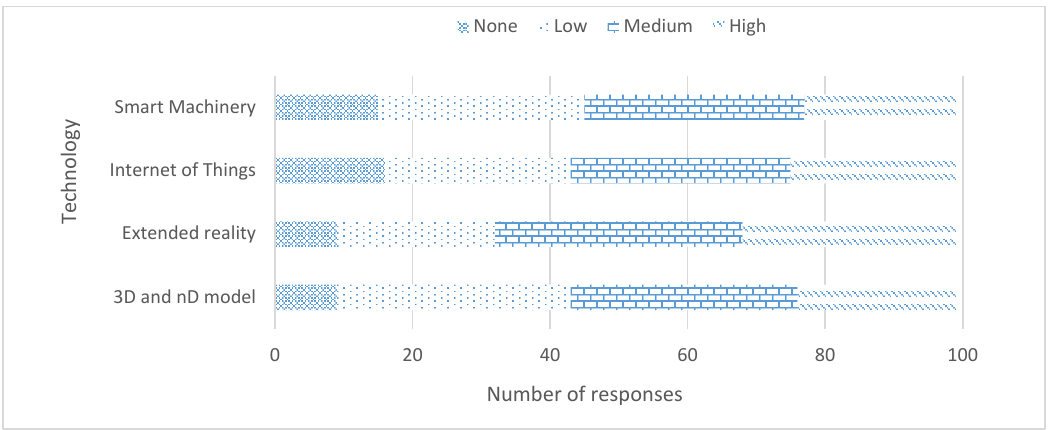
Figure 2. Average technology utilization levels of the Chinese practitioners.